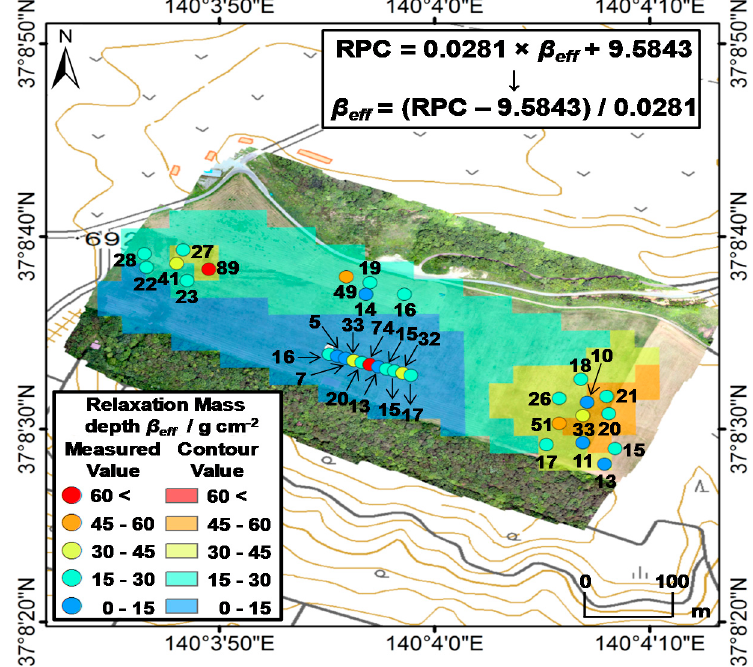
Figure 11. Distribution of β eff based on the RPC obtained for the farm.